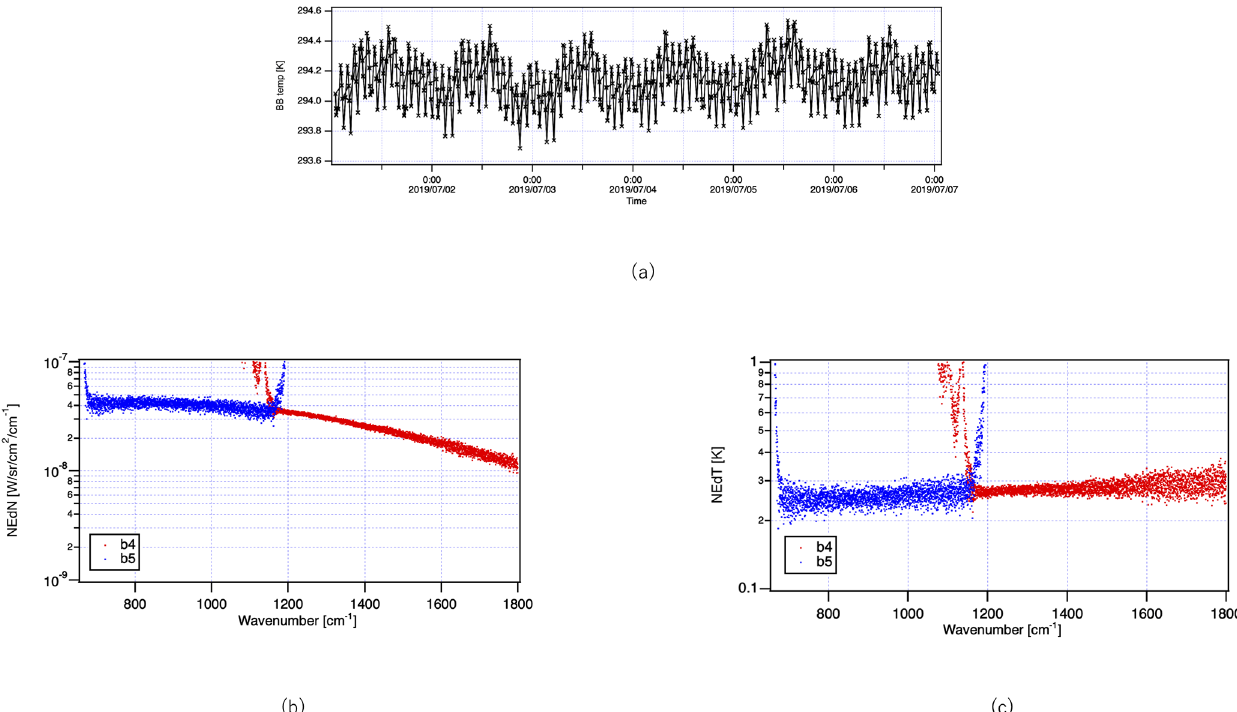
Figure 13. Noise characteristics of TIR bands 4 and 5: ( a) typical time series of blackbody temperature, (b ) noise equivalent differential radiance (NEdN), and (c) noise equivalent differential temperature (NEdT).